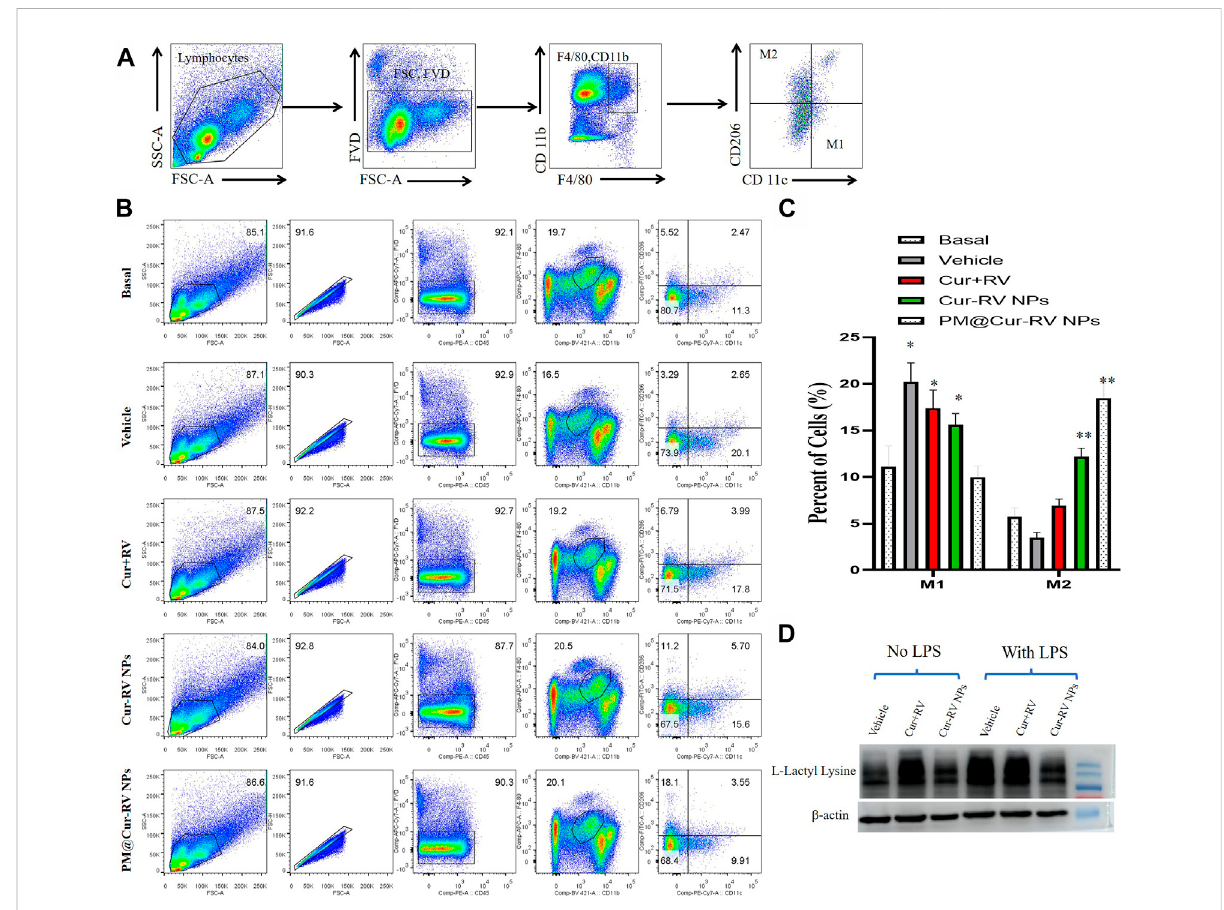
FIGURE 7 PM@Cur-RV NPs reduce lung in fl ammation by inducing macrophage towards to M2 polarization. Flow cytometric analysis of macrophages derived from in fl ammatory lungs treated with different formulations of Cur and RV for 24 h. (A) The scheme illustrates the selection of M1-or M2- positive cells from isolated single cells of lung tissues. In brief, we fi rst gated out the live cells, and then gated out the F4/80-positive cells. In this subgroup, we used CD11c and CD206 as markers to identify M1 or M2 macrophages. F4/80+, CD11c+, CD206-cells are zoned as M1 cells, F4/ 80+, CD11c-, CD206+ cells are marked as M2 cells. (B) The representative images of cell distribution pattern in sepsis mice treated with different formulations of drugs. (C) The quantitative analysis of percentage of total M1 (F4/80+) macrophages and M2 (CD206+) macrophages in LPS- challenged lungs (n = 4/group; ** p < 0.01, *** p < 0.0001 versus PBS-treated group; ## p < 0.001, ### p < 0.001 versus Nar-treated group). (D) Representative western blotofL-Lactyl LysineexpressioninRAW264.7cellsafter 24 htreatment withvehicleordifferentformulationsofCur-RV. β - actin was used as a loading control. It shows that Cur-RV signi fi cantly decreased the lactic acid modi fi cation in LPS-induced